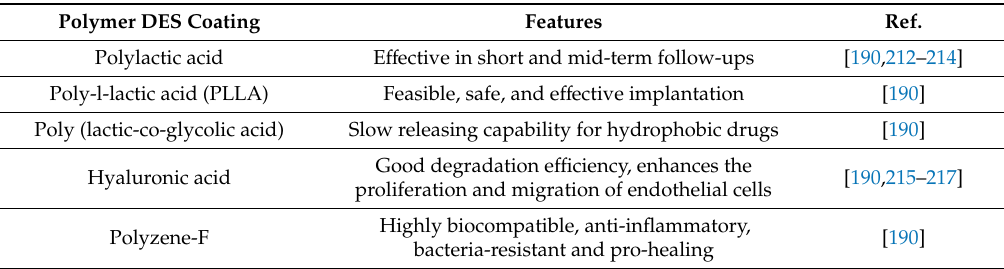
Table 5. Common polymers used in